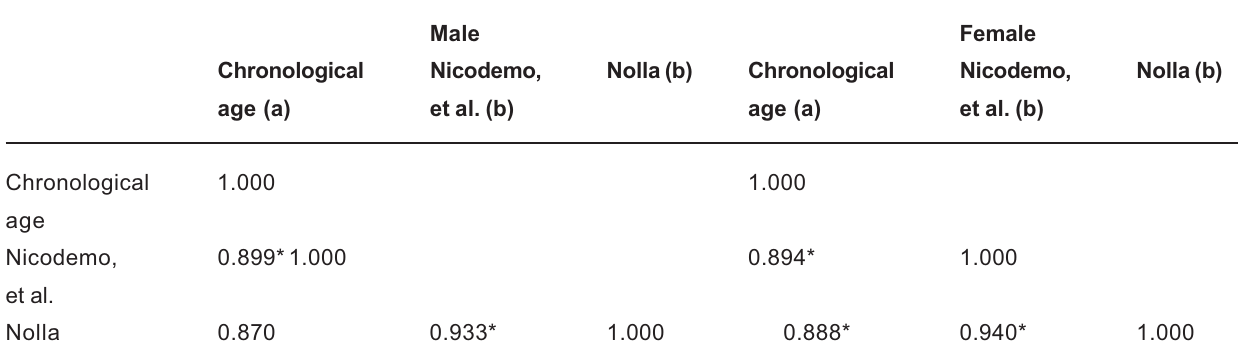
Different letters indicate statistically significant difference by Student-Newman-Keuls test at 5% significance